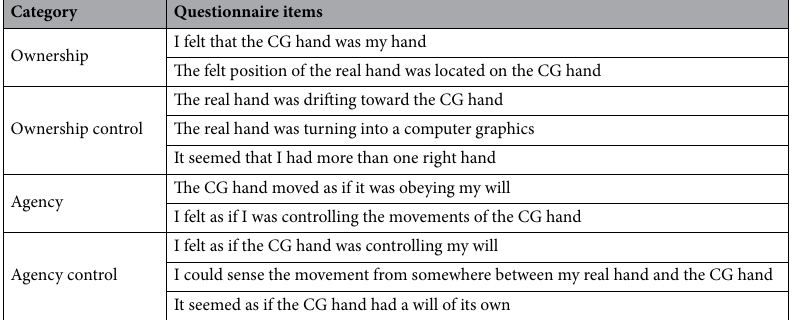
Table 1. Questionnaire items for measuring subjective aspects of the computer graphics (CG) hand in experiment 1. Participants rated their level of agreement with each item on a 7-point scale, ranging from -3 (strongly disagree) to + 3 (strongly